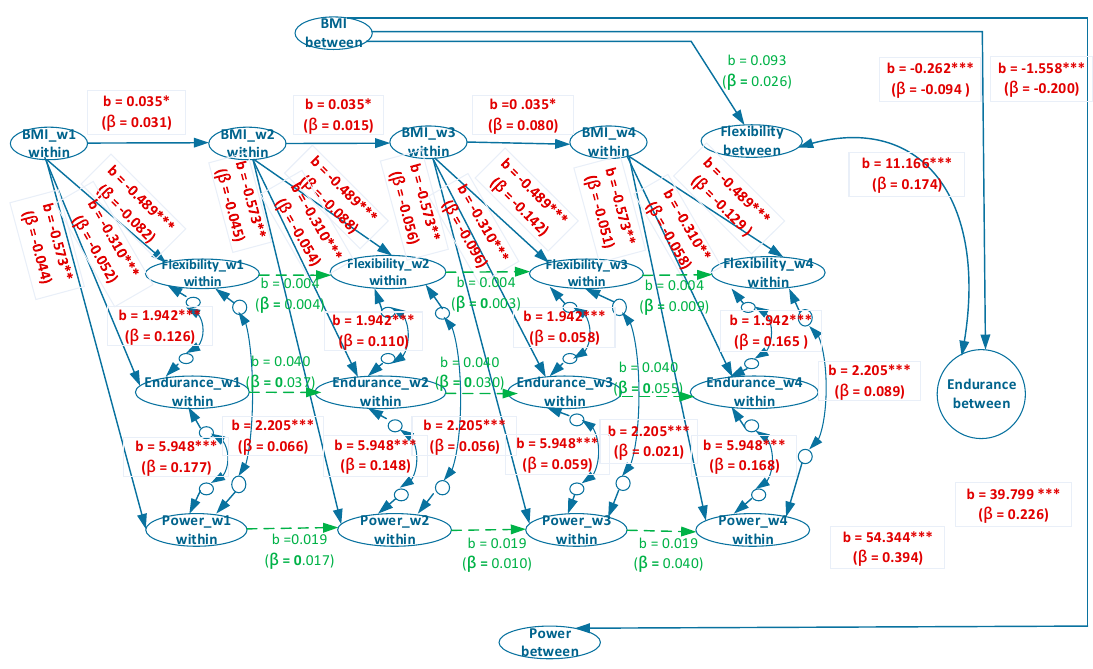
Figure 4. Simplied representation of the estimated random-intercept panel model for female participants.